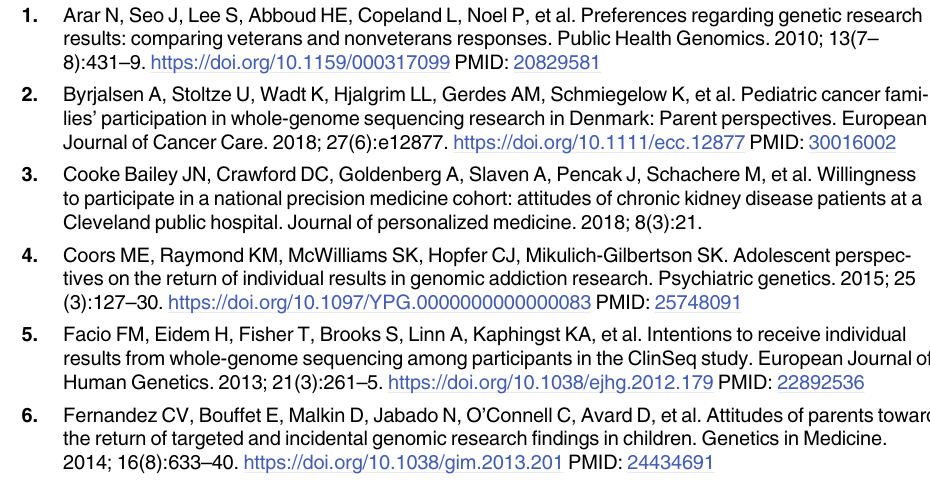
S2 Table. Data extraction